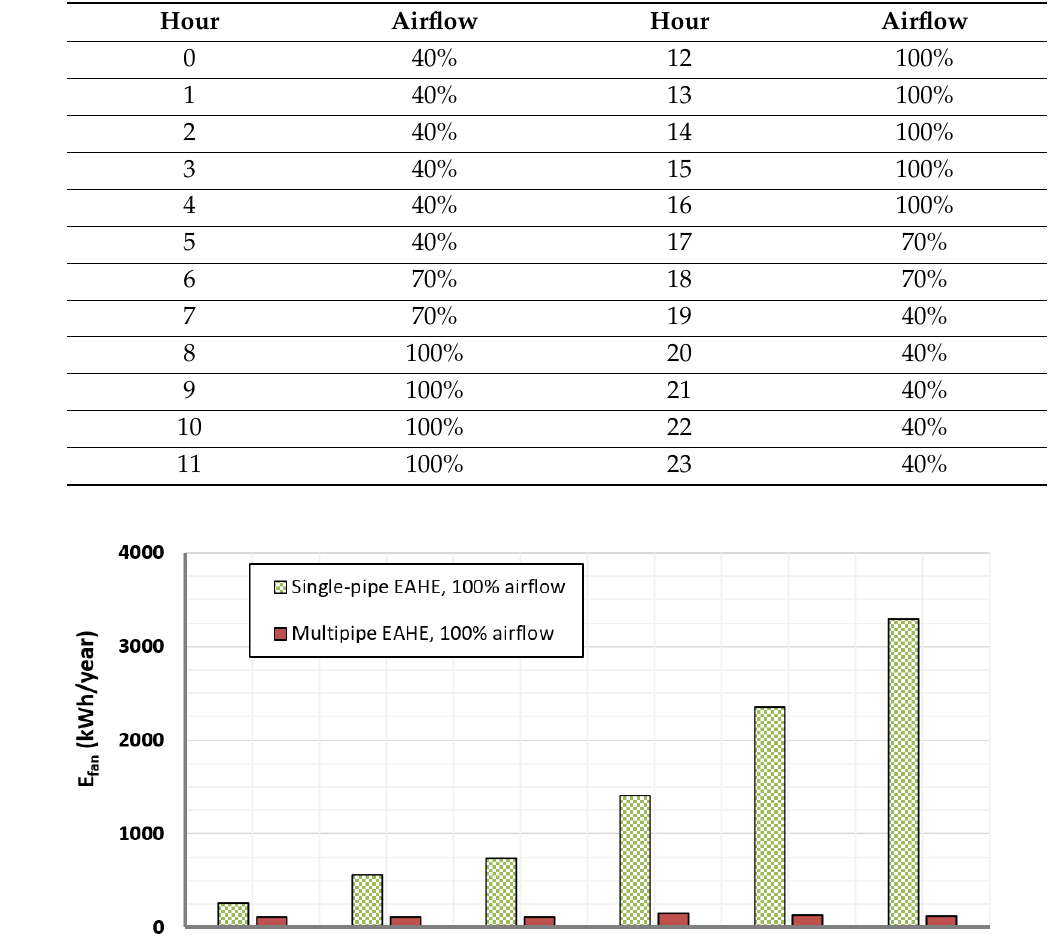
Table 4. Daytime ventilation airflow schedule assumed during calculations.